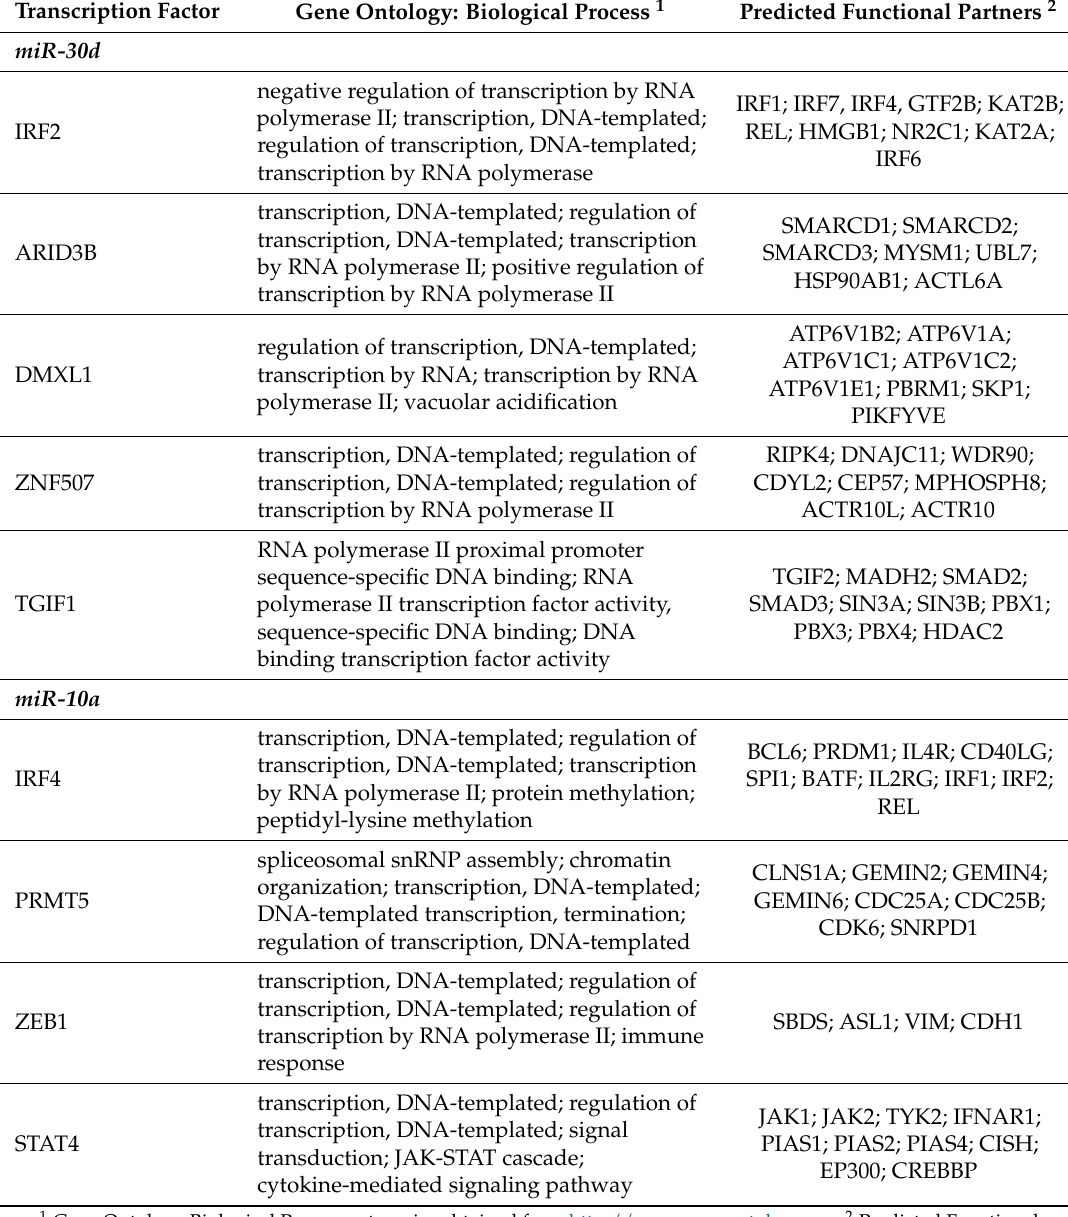
Table 2. Transcriptional factors identified in yeast one-hybrid screening of the chicken miR-30d and miR-10b